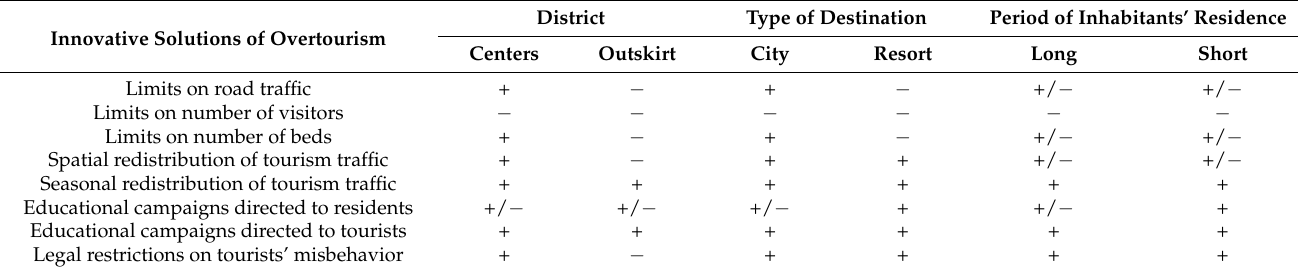
Table 2. Potential innovative solutions of overtourism and their usefulness according to particular groups of inhabitants. District Type of Destination Period of Inhabitants’ Residence Innovative Solutions of Overtourism Centers Outskirt City Resort Long Short Limits on road